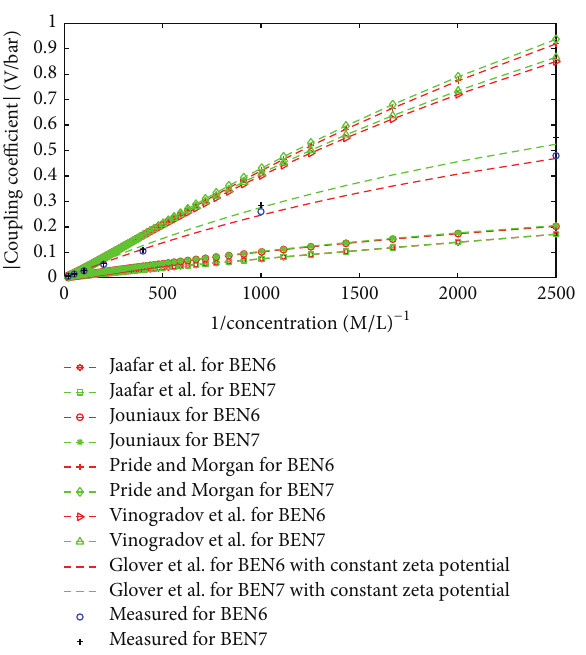
Figure 6: Coupling coefficient as a function of electrolyte concen- tration from different